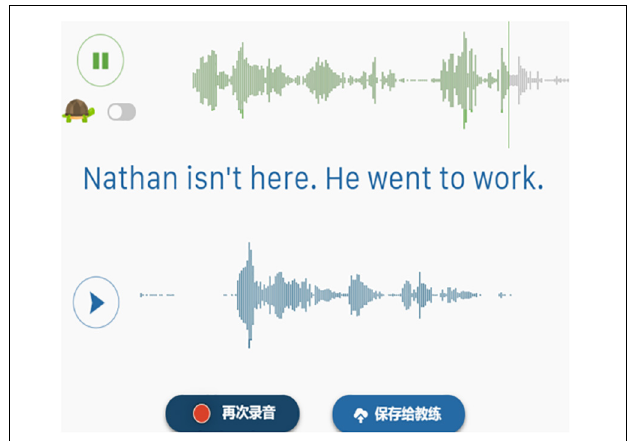
FIGURE 4 | Controlled oral practice with CMC.